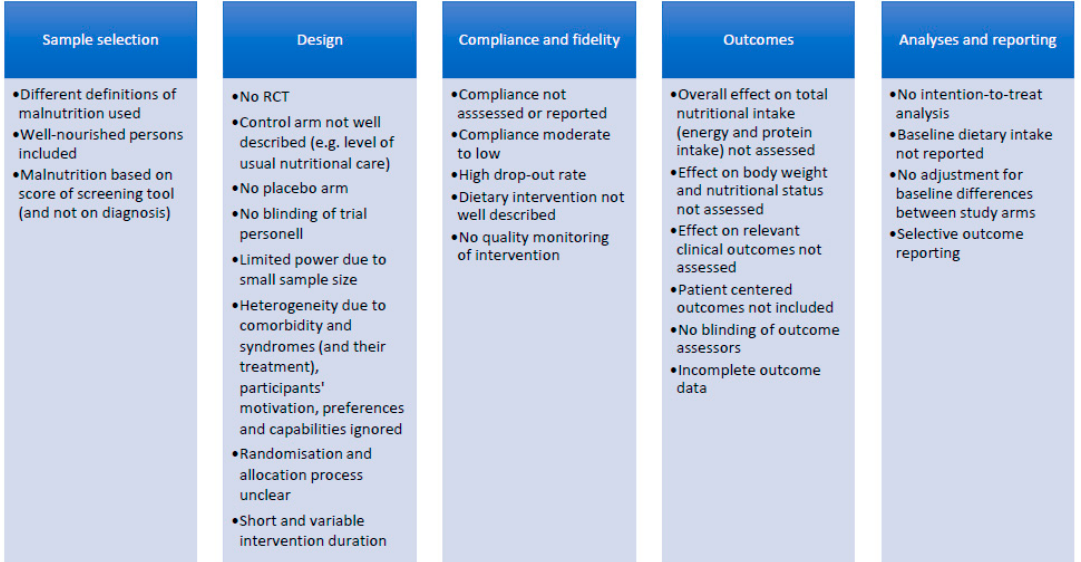
Figure 1. Limitations of previous studies investigating the effect of nutritional interventions in malnourished older people.